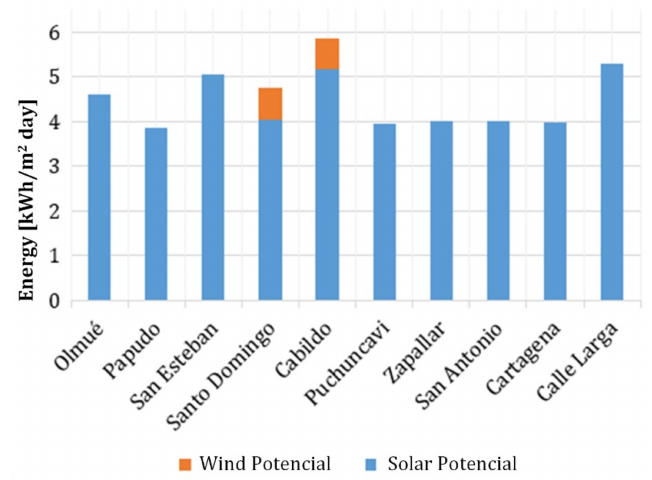
Figure 2. Average daily energy potential as a function of annual energy potential, by surface area and per sector.